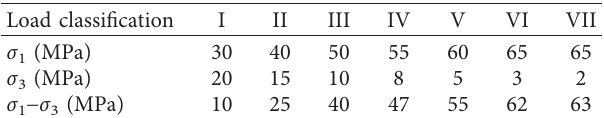
Table 4: Unloading confining pressures with axial compression triaxial test scheme.